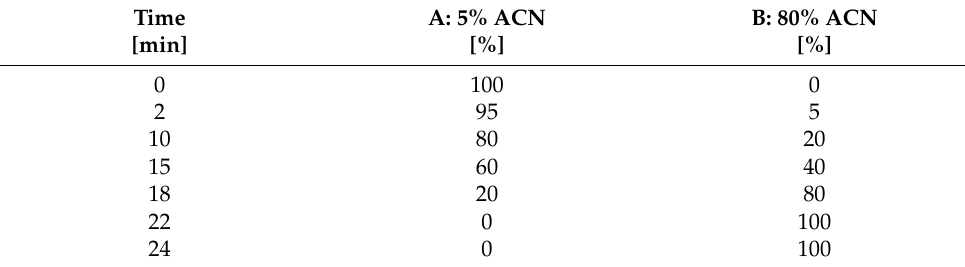
Table 3. Gradient of mobile phases used for HPLC based PheC